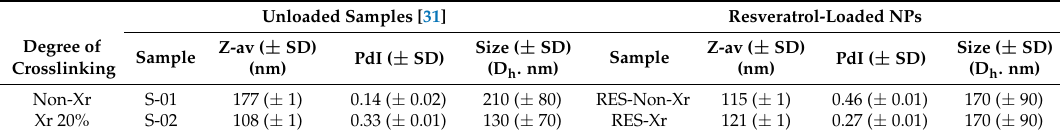
Table 3. Comparison of Z-average, polydispersity index (PdI), and hydrodynamic diameter (D h , determined by DLS) of non-cross-linked NP (Non-Xr) and stabilized NP at 20% of cross-linking (Xr) (unloaded or loaded with RES).